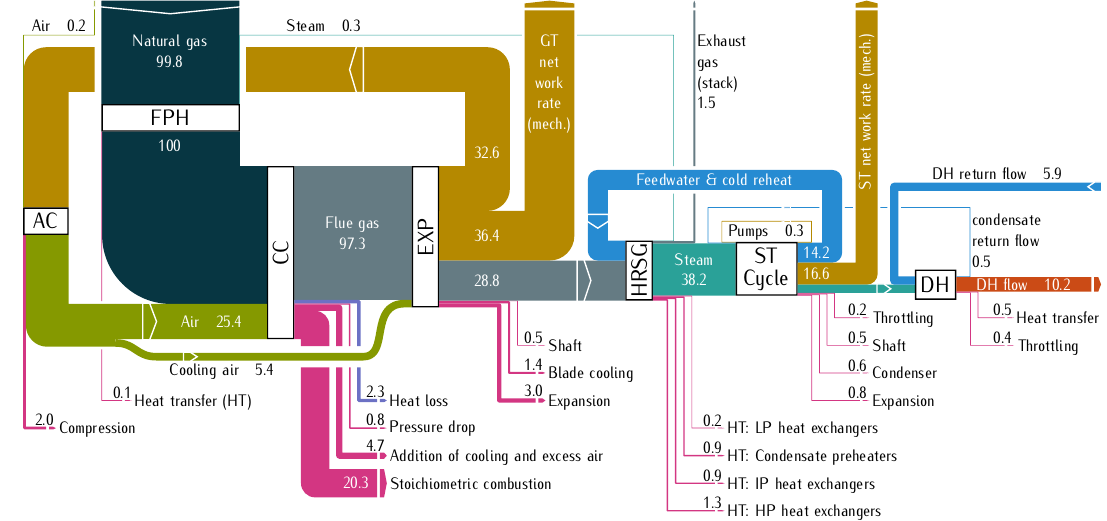
Figure 7. True to scale exergy flow diagram (Grassmann chart) of the CCGT process. Magenta colored arrows represent the exergy destruction